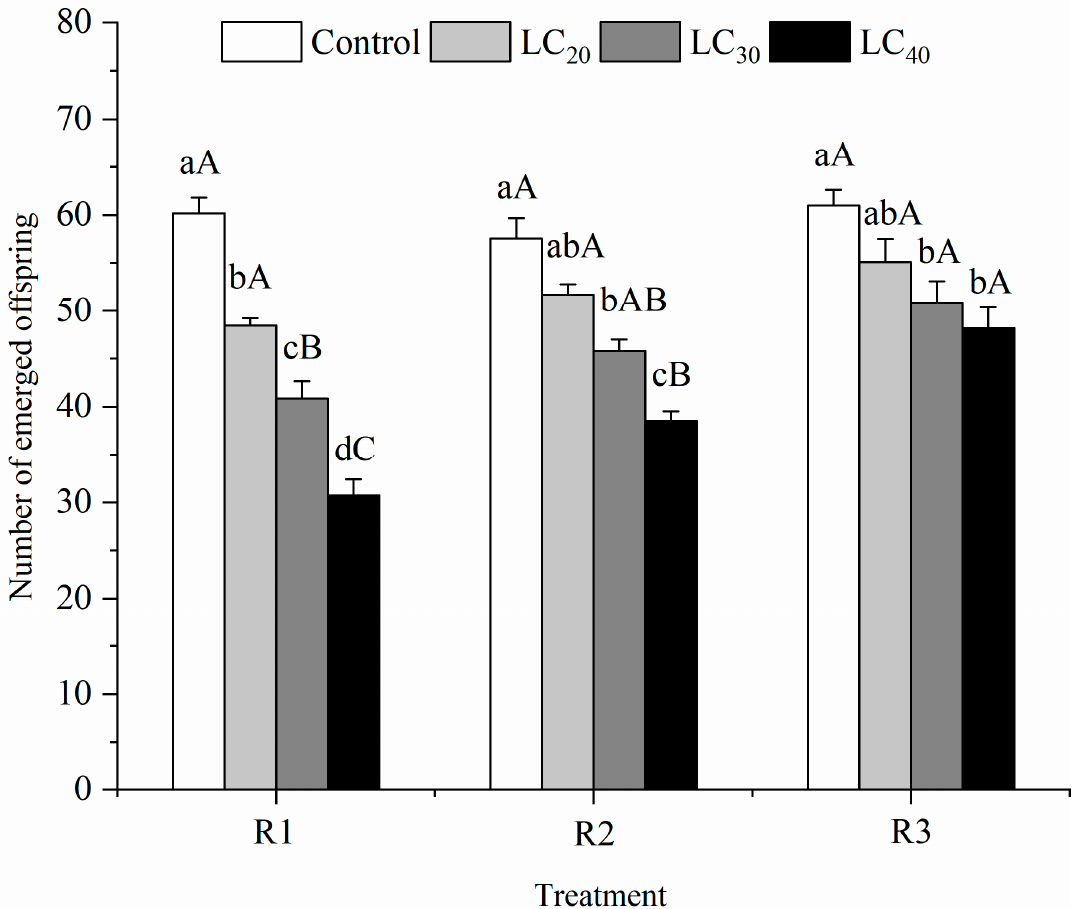
Figure 3. A number of emerged offspring (mean ± SE) of Tetrastichus howardi at different concentra- tions of indoxacarb were treated with three methods. R1 (Routes of exposure 1) is adult exposure to pesticide residues on the glass tube, the LC 20 , LC 30 , LC 40 , and water control were used. R2 (Routes of exposure 2) is adult exposure to pesticide residues on the host, the LC 20 , LC 30 , LC 40 , and water control were used. R3 (Routes of exposure 3) is larval exposure to pesticides through host exposure, the LC 20 , LC 30 , LC 40 , and water control were used. Means in the same routes of exposure followed by different lowercase letters represent a significant difference in different concentrations of pesticide on T. howardi. Means in the same concentrations followed by the same uppercase letter were not significantly different in different routes of exposure based on Tukey’s multiple range test at the 5% level.